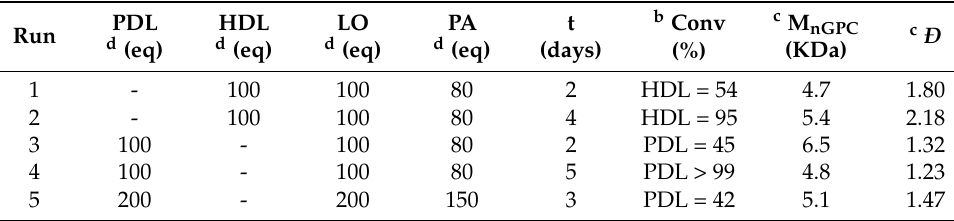
Table 1. Ter-polymerizations of LO, PA and macrolactones promoted by 1 a